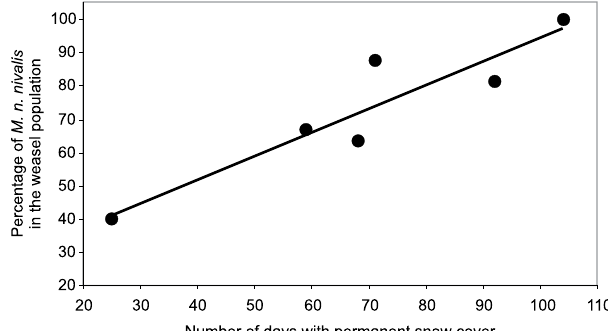
Figure 1. Relationship between the share of M . n . nivalis in summer/autumn population of weasels inhabiting the Białowieża Glade and number of days with permanent snow cover during the preceding winter (data for years 1997, 2003–2007).